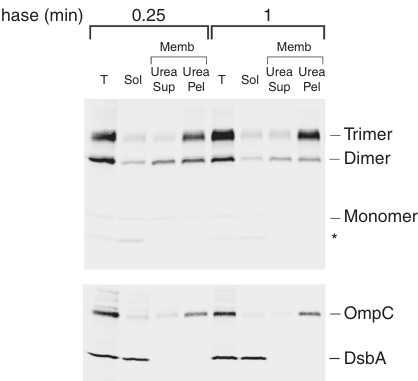
Fig. 5 Localization of oligomeric forms of UpaG Δ 2. AD202 transformed with pRS4 [P trc - HA-upaG Δ 2(Y1735am) ] and pDULE-Bpa were radiolabeled, UV irradiated, and fractionated. Immunoprecipitations were conducted using an anti-HA antiserum (top gel) or anti-OmpC and anti-DsbA antisera (bottom gel). The truncated form of HA-UpaG Δ 2 that resulted from translation termination at the amber codon is denoted with an asterisk. T, total cell extract; Sol, soluble protein; Memb, cell membranes; Urea